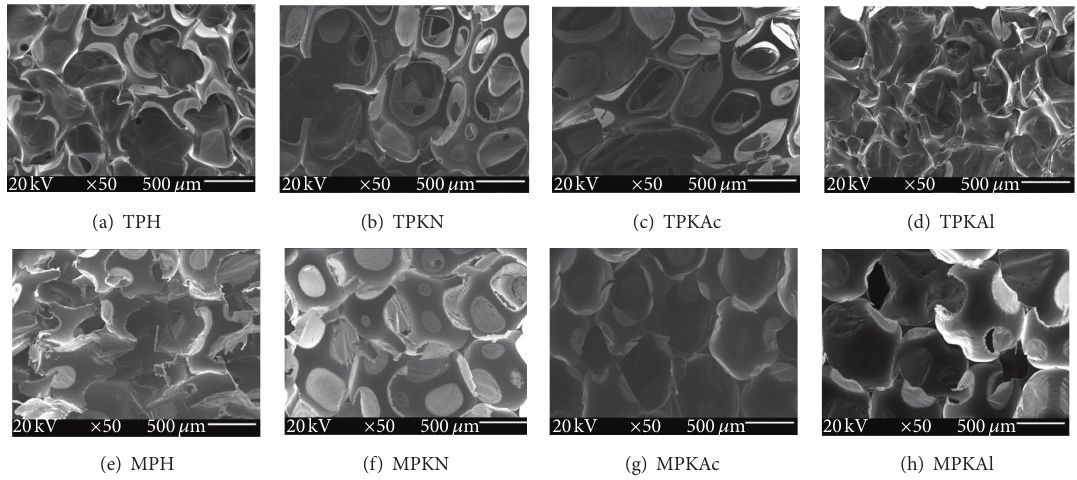
Figure 3: SEM images of PU-keratin membranes; ((a)–(d)) with TDI; ((e)–(h)) with MDI.